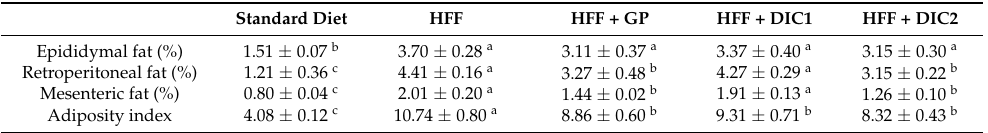
Table 3. Distribution of adipose tissue of rats fed a HFF diet supplemented or not with grape pomace subjected or not to